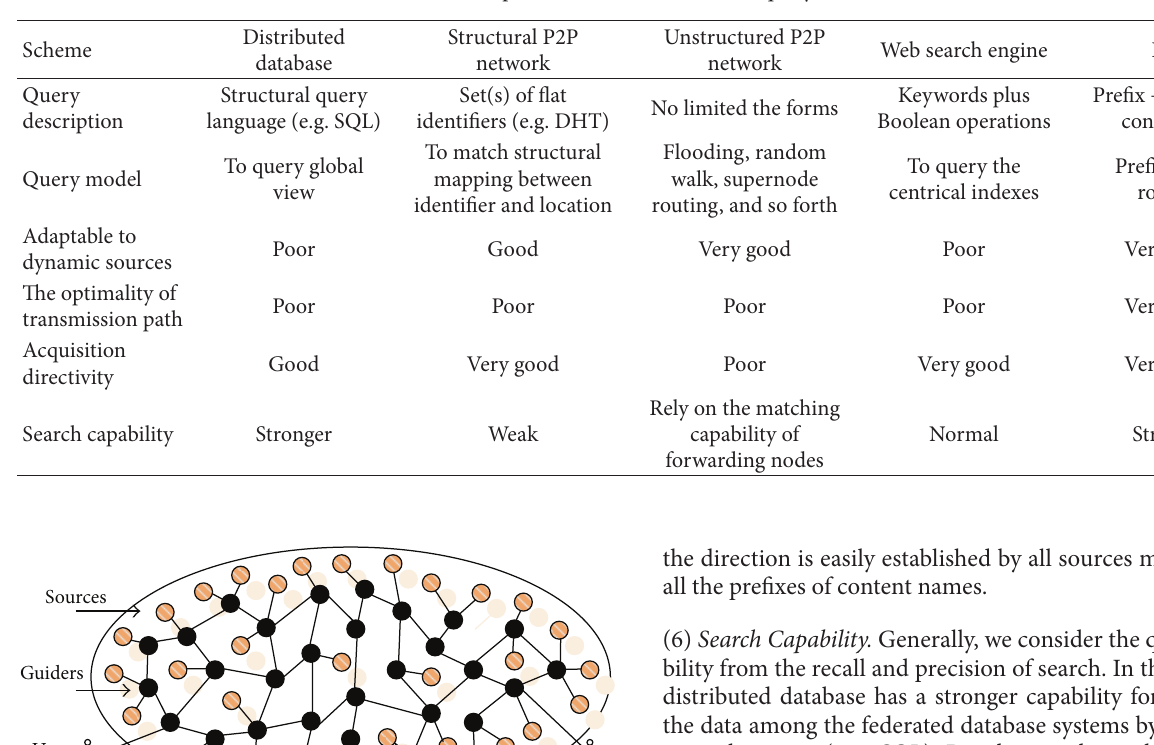
Table 3: Comparison of distributed media query schemes.